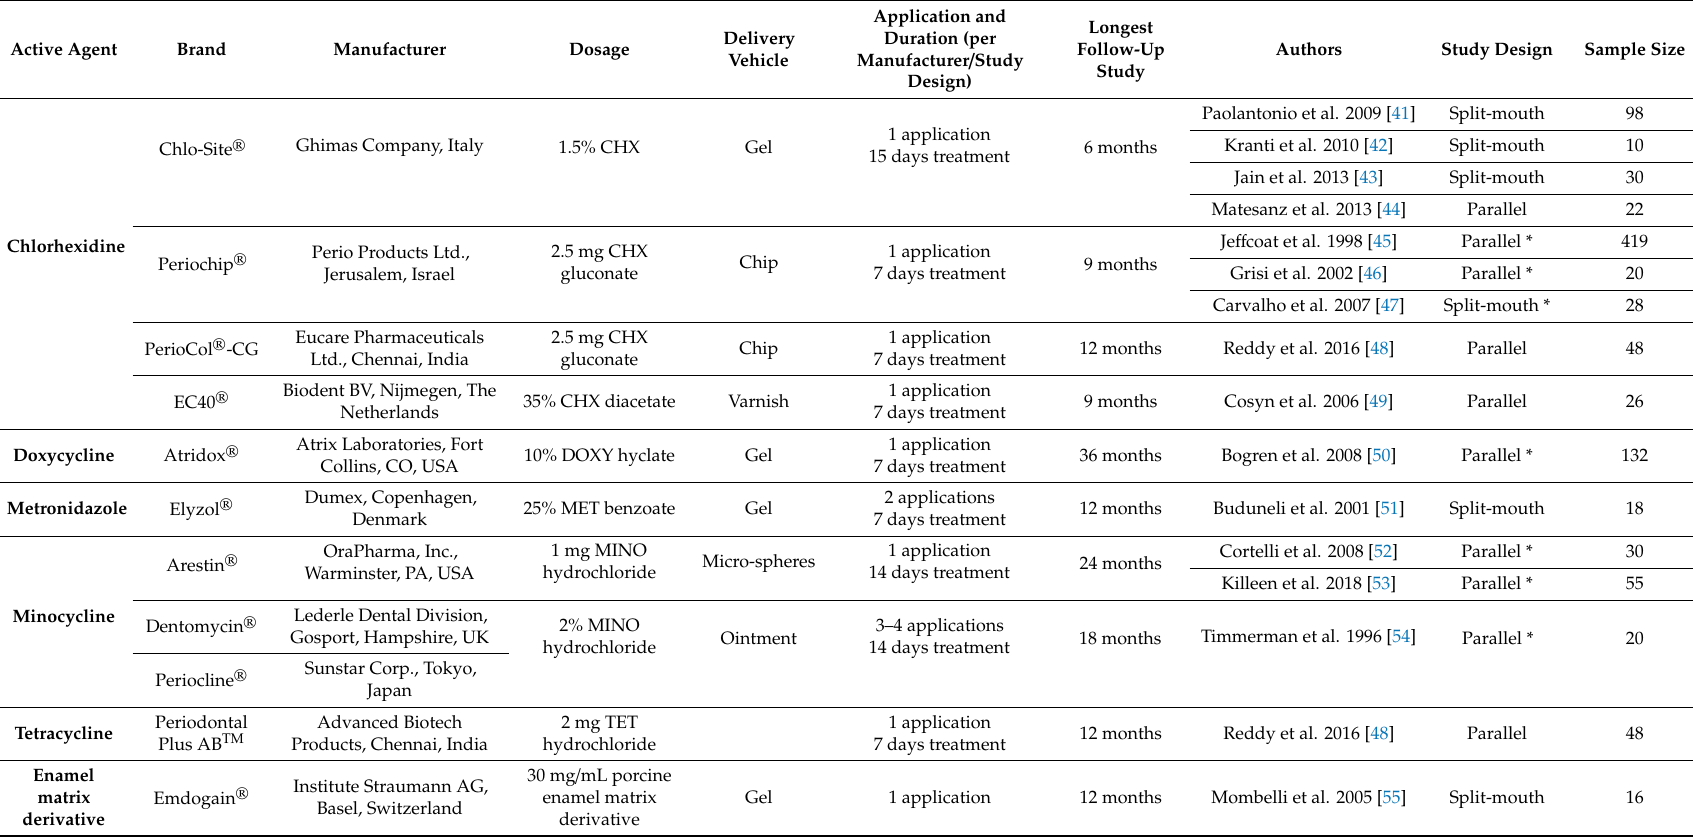
Table 1. Summary of clinically tested commercial LDA for nonsurgical periodontal therapy based on longest follow-up period.